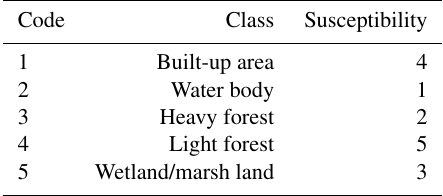
Table 2. Classification of the landuse at Orashi River Basin. Code Class Susceptibility